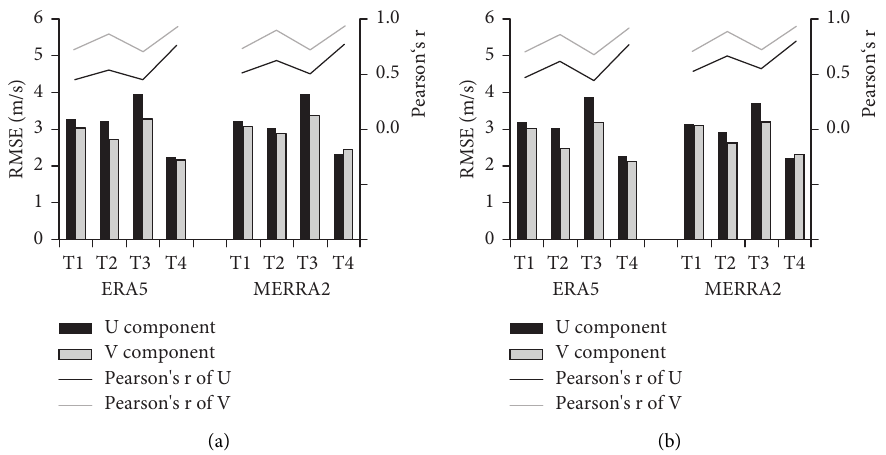
Figure 8: RMSE and Pearson’s r for the U/V components of wind predicted by ERA5 and MERRA2 based on the MLR (a) and ANN (b) downscaling